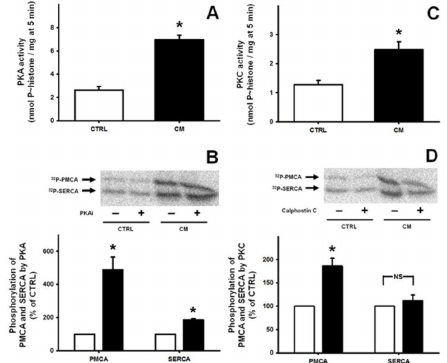
Figure 6. PKA and PKC activities and PKA- and PKC- mediated regulatory phosphorylations of PMCA and SERCA from vas deferens tissue. (A) Cyclic AMP- dependent protein kinase (PKA) activity in vas deferens homogenates from four CTRL (empty bar) and four CM (black bar) preparations. Results are mean ± SEM. (B) Upper panel: representative hydroxylamine-resistant (kinase-mediated) autoradiograms of 32 P-phosphorylations of vas deferens PMCA ( 32 P-PMCA) and SERCA ( 32 P-SERCA), as indicated by arrows on the left side of the panel. Assays were carried out in the absence (−) or presence (+) of 10 nM PKAi, the specific PKA inhibitor, as shown on the corresponding abscissa . Lower panel; graphic representation of PKAi-sensitive 32 P- phosphorylations in vas deferens from three different preparations from CTRL (empty bars) and CM (black bars) rats. The densitometric values were corrected by simultaneous immunodetection of each Ca 2+ -ATPase, which are shown in the Western blots of Figure 5 (D and E). Each bar corresponds to the difference between phosphorylations in the absence and presence of PKAi, and values for each Ca 2+ -ATPase are expressed as percentages of the corresponding CTRL. The SEM were calculated from absolute values and converted to percentage values. *P<0.05 vs. the corresponding CTRL. (C) Calphostin-sensitive protein kinase C (PKC) activity in vas deferens homogenates from four CTRL (empty bar) and four CM (black bar) preparations. Results are mean ± SEM. (D) Upper panel: representative hydroxylamine-resistant (kinase- mediated) autoradiograms of 32 P-phosphorylations of vas deferens PMCA ( 32 P-PMCA) and SERCA ( 32 P-SERCA), as indicated by arrows on the left side of the panel. Assays were carried out in the absence (−) or presence (+) of 10 nM calphostin C, an inhibitor of both classical and novel isoforms of PKC, as shown on the corresponding abscissa . Lower panel: graphic representation of calphostin C-sensitive 32 P- phosphorylations carried out with vas deferens from three different preparations from CTRL (empty bars) and CM (black bars) rats. The densitometric values were also corrected by immunodetection of the ATPases, as described above for PKA. Each bar corresponds to the difference between phosphorylations in the absence and presence of calphostin C, and values are presented as percentages of the corresponding CTRL. The SEM were calculated from absolute values and converted to percentages. *P<0.05 vs. the respective CTRL.